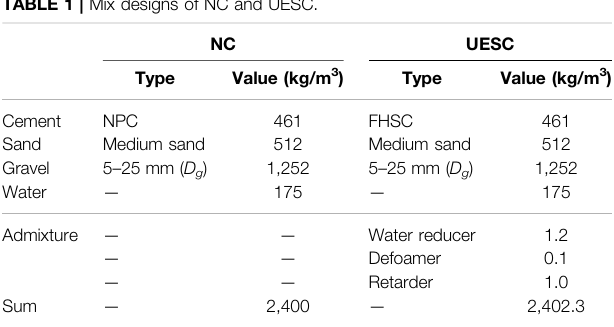
TABLE 1 | Mix designs of NC and UESC.